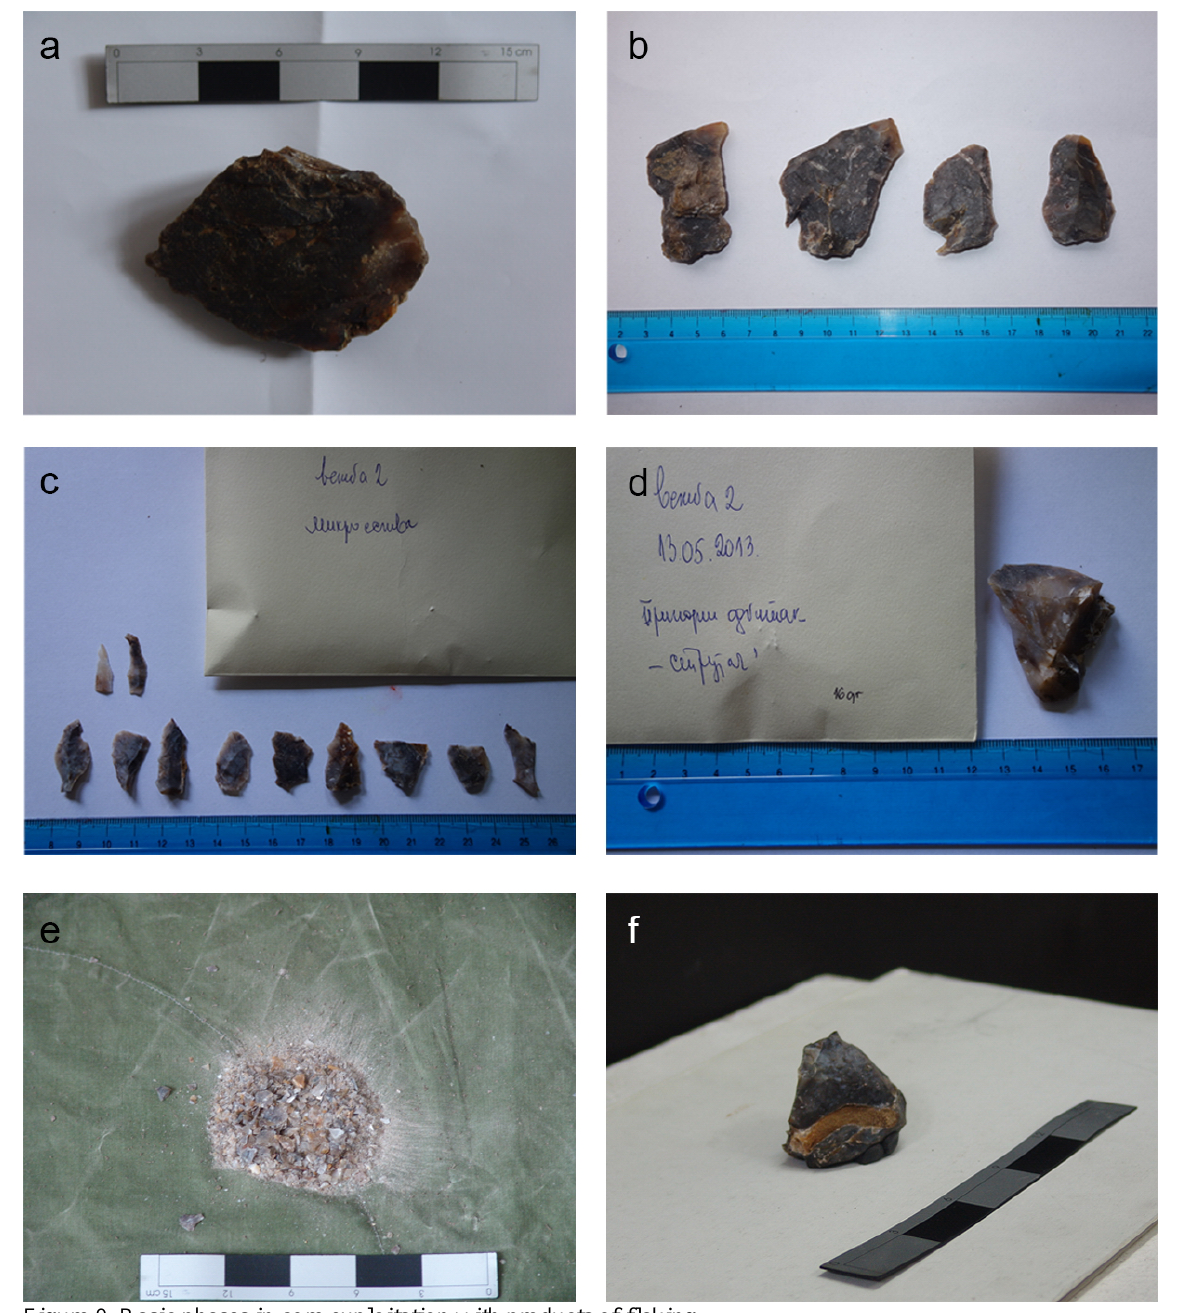
Figure 9. Basic phases in core exploitation with products of